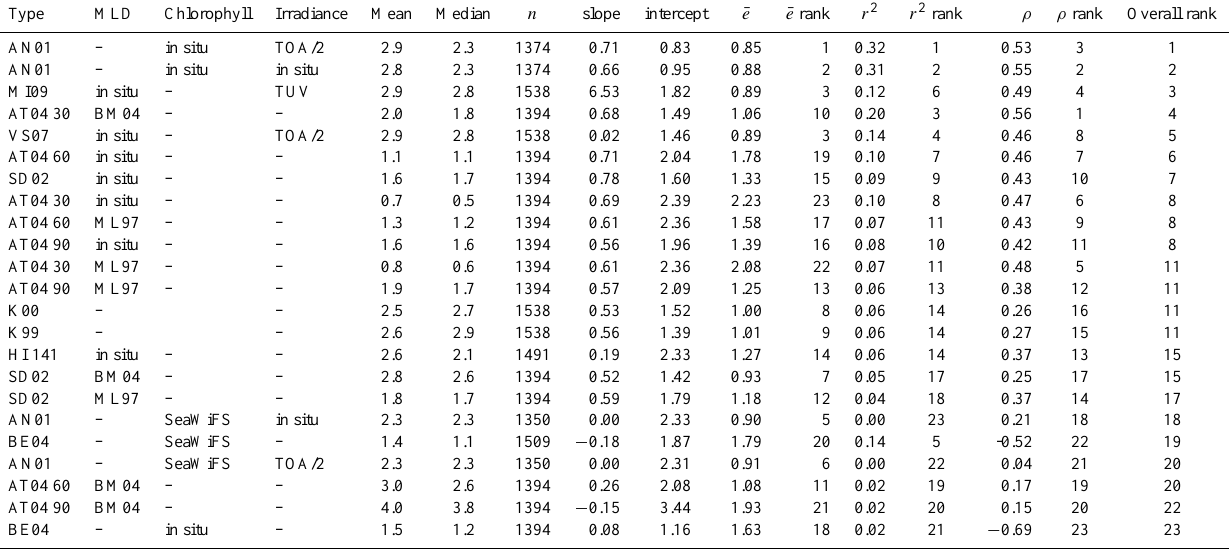
Table 2. A summary of predicted DMS values and the relation of these to the measured values. The table contains the predictor type (algorithm or climatology code), mixed layer depth (MLD), chlorophyll and irradiance data used, the mean and median DMS (nM). Also n , the slope and the intercept of the regression, the mean residual ( ¯ e ,nM), the correlation coefficient ( r 2 ), and Spearman’s rank correlation coefficient ( ρ ) are given. All ρ are significant at p < 0.01, excepting AN01 with SeaWiFS chlorophyll and TOA/2 irradiance. The columns to the right of ¯ e , r 2 and ρ are the rank of that metric in relation to the other predictors, numbered 1–23, 1 being the best performing. The final column is the overall position, the order (smallest to largest) of the sum of the ranks for the metrics. For reference, the mean and median of all measured DMS data were 2.5 and 2.9nM. For VS07 and MI09, the best performing couplets are also given (in Table